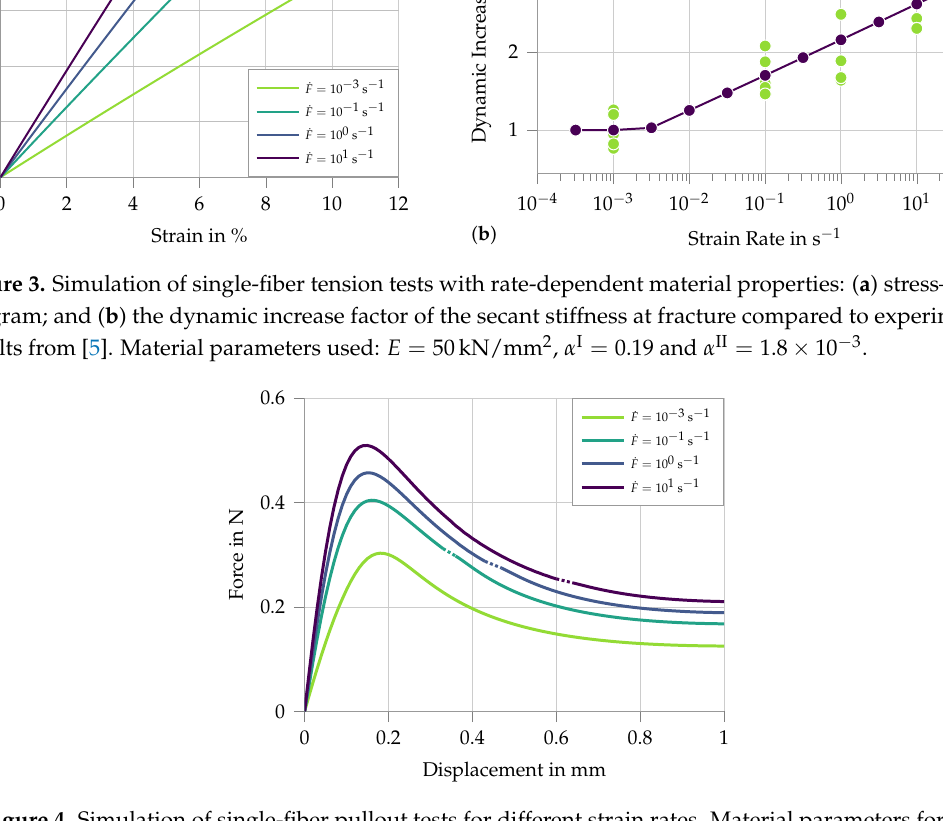
Figure 4. Simulation of single-fiber pullout tests for different strain rates. Material parameters for the free length: E = 50kN/mm 2 , α I = 0.19 and α II = 1.8 × 10 − 3 . Material parameters for the embedded fiber: E = 300kN/mm 2 , α I = 0.08, α II = 1.8 × 10 − 3 , D ∞ = 0.998, D rate = 2.0 and D shape =